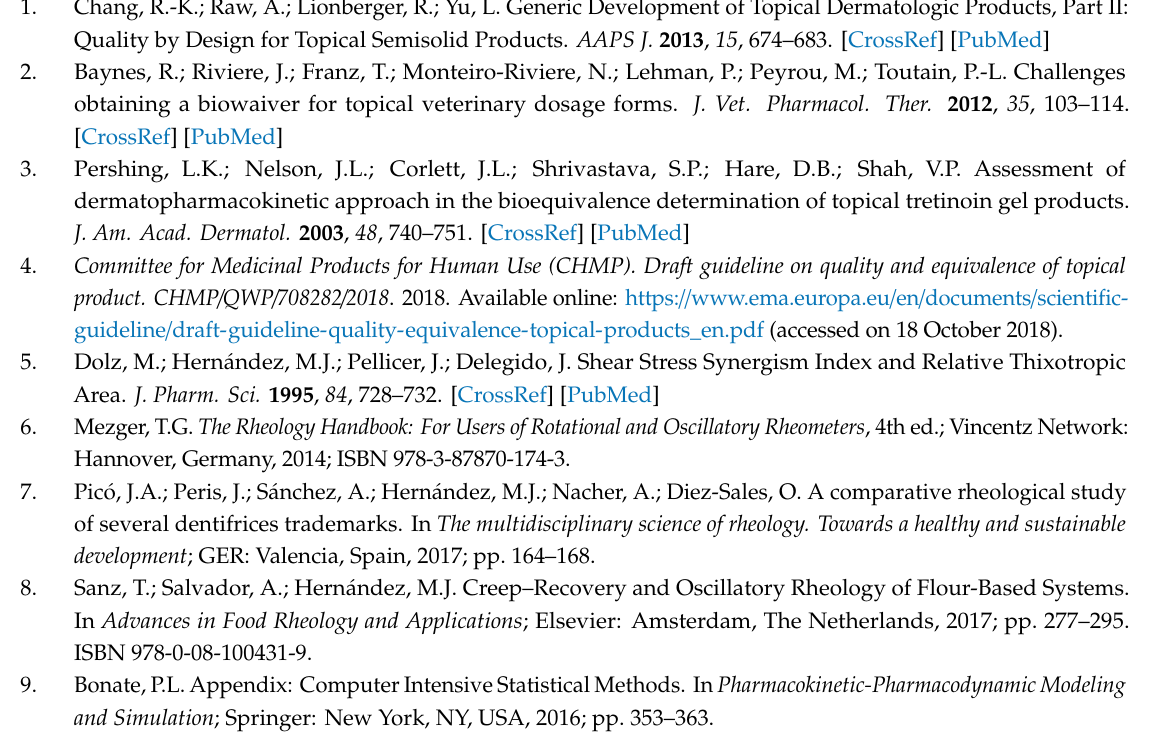
Figure S1: Representative rheograms of evaluated batches. Figure S2: Bootstrap analysis of rheological parameters using 6 replicates - 1 reference batch versus 1 reference batch. Figure S3: Bootstrap analysis of rheological parameters using 24 replicates - 1 reference batch versus 1 reference batch. Figure S4: Bootstrap analysis of rheological parameters using 6 replicates – 5 reference batches versus 5 references batches. Figure S5: Bootstrap analysis of rheological parameters using 24 replicates – 5 reference batches versus 5 references batches. Table S1: Raw